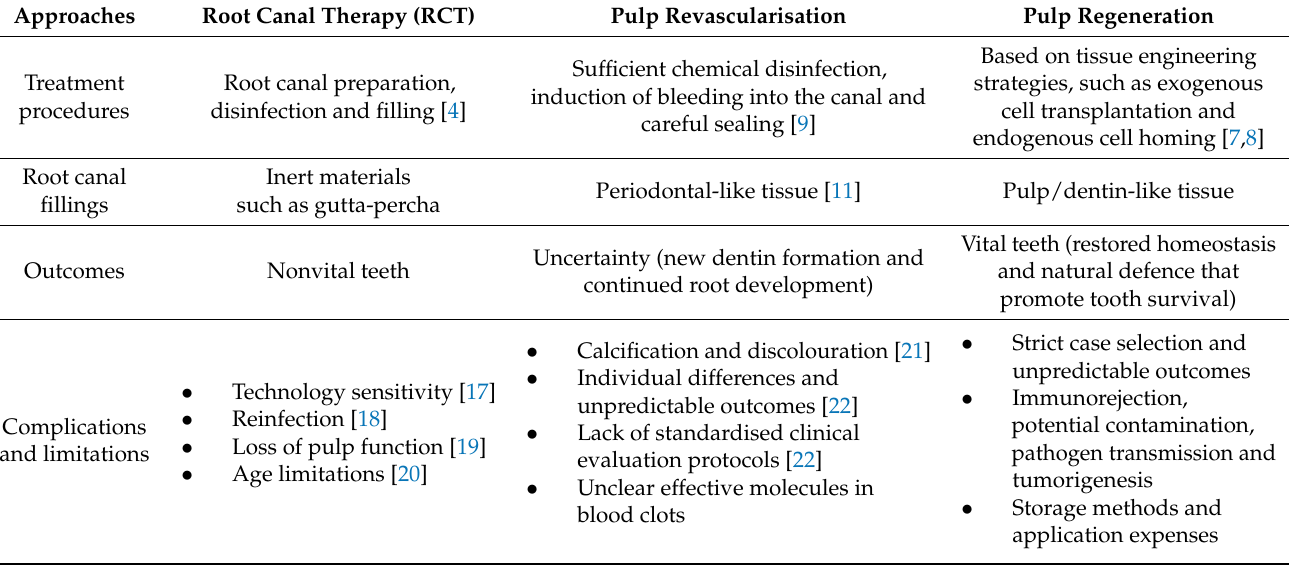
Table 1. Comparison of RCT, pulp revascularisation and pulp regeneration via treatment procedures, root canal fillings, outcomes, complications, and